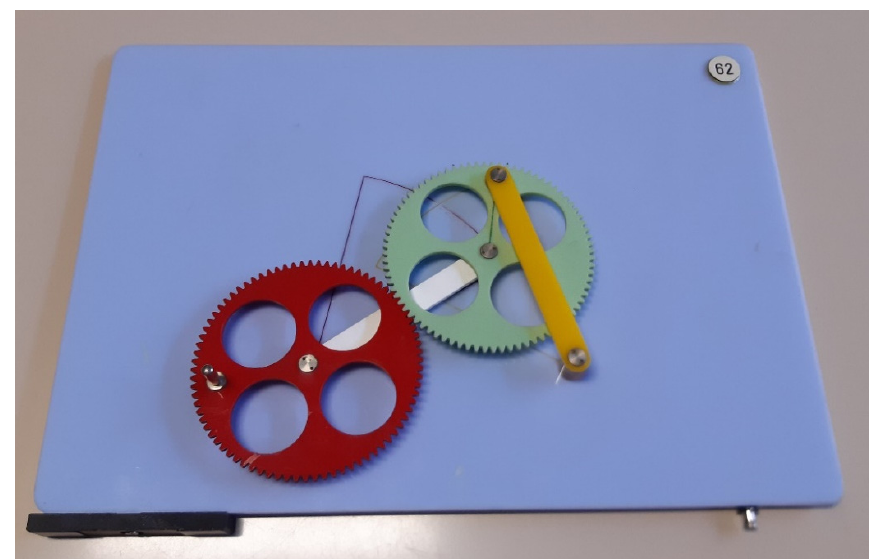
Figure 14. Four-bar linkage mechanism with an actuated connection rod and the maximum angular displacement of the rocket engraved on the base.